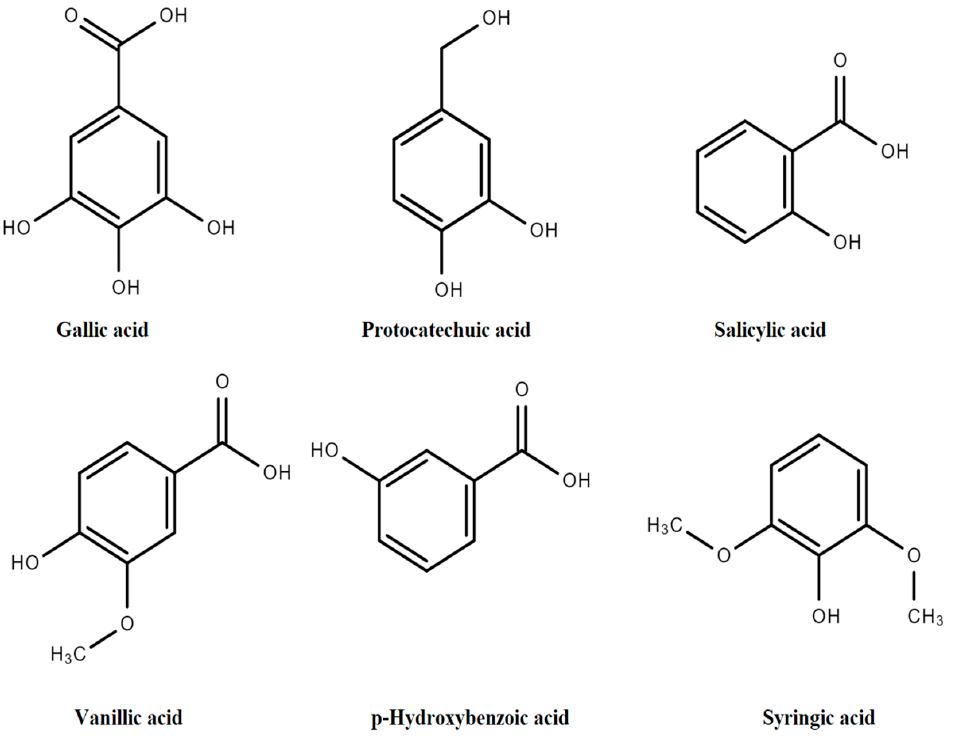
Figure 3. Derivatives of hydroxybenzoic acids.